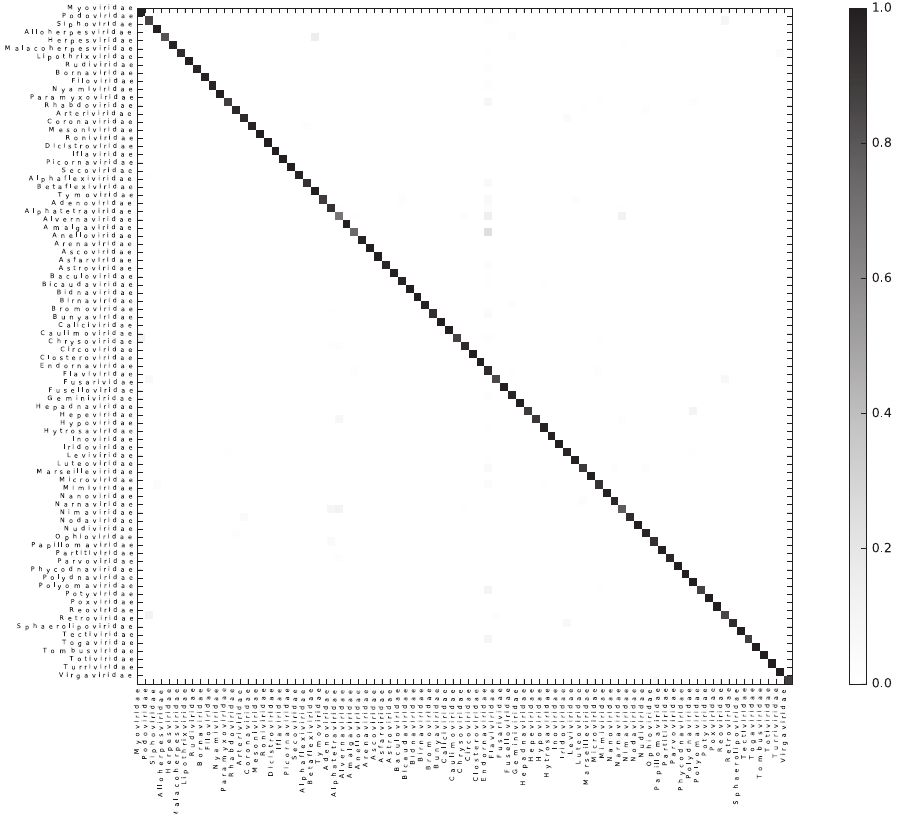
Figure 4. Random forest accurately classifies genomes into their respective families. A heatmap rep- resenting the confusion matrix obtained after classifying viral genomes at the family level. The color code indicates the proportion of genomes of the Family in the x-axis classified as a genome of the Family in the